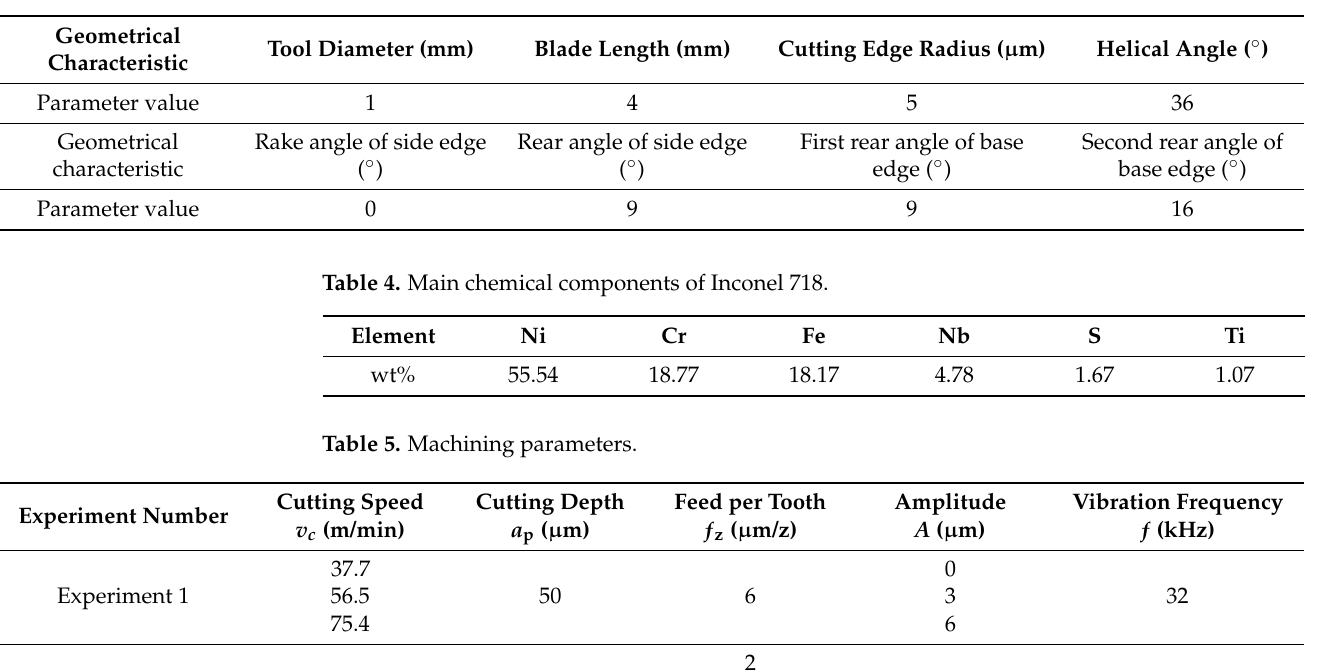
Table 3. Geometrical parameters of micromilling tool.